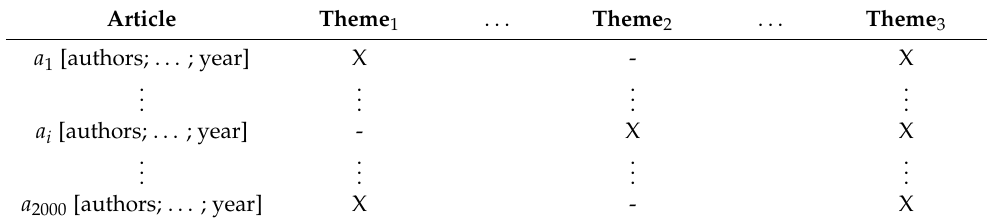
Table 3. Themes addressed by each